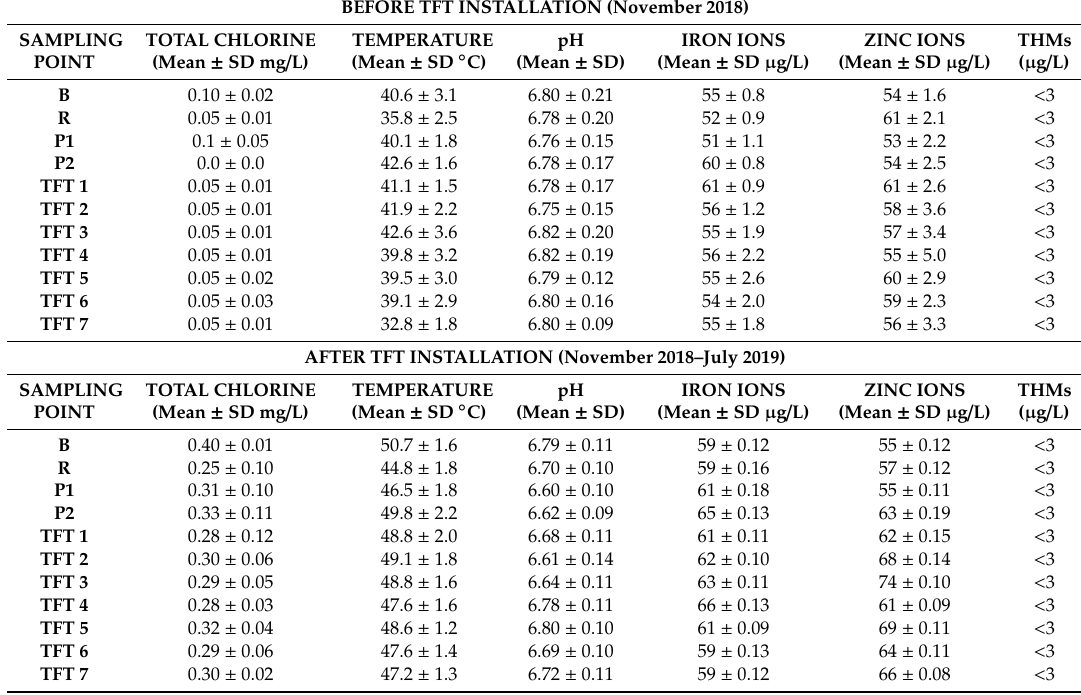
Table 3. Mean values of physical–chemical and chemical parameters assessed at each sampling points before and after TFT installation in Hospital 3. (B = boiler; R = recirculation; P1 = point 1; P2 = point 2;